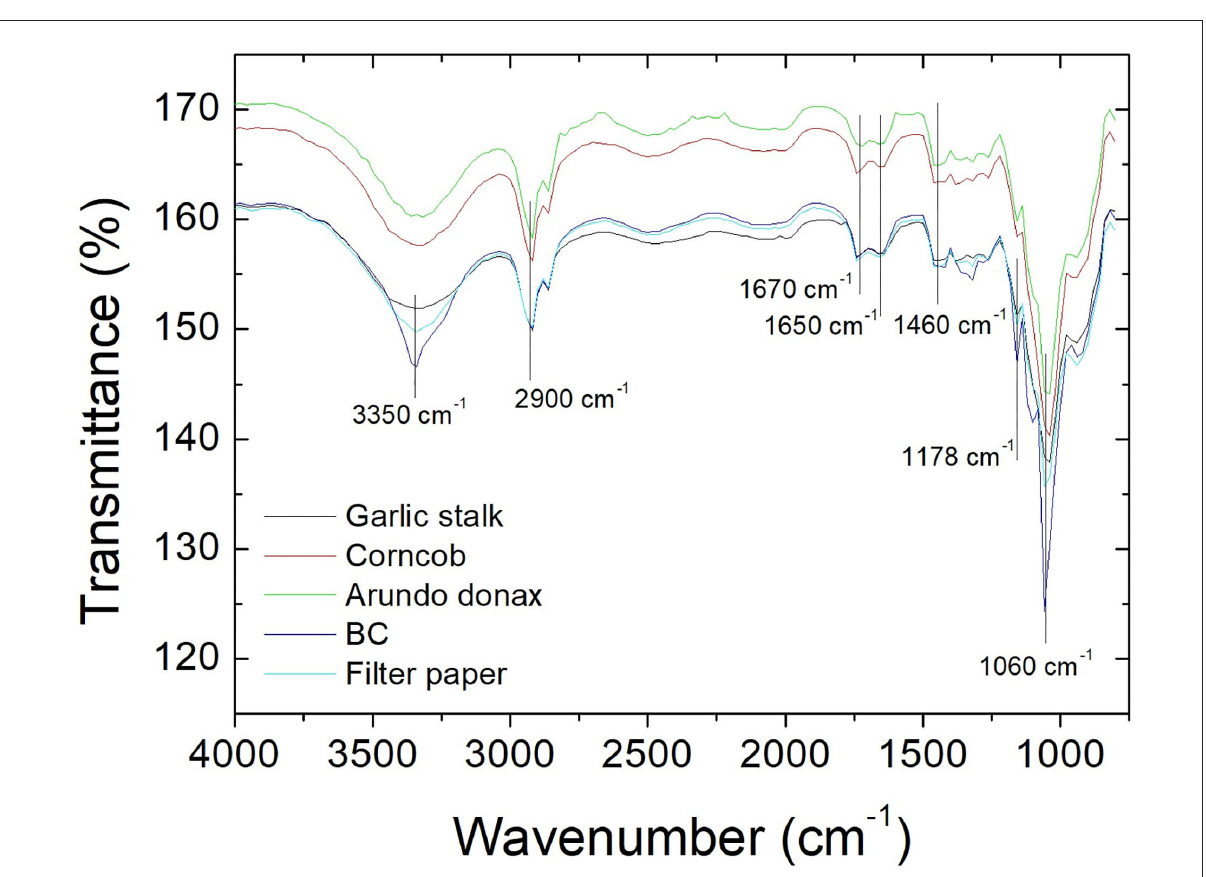
FIGURE3 FTIR-ATR spectra of cellulose extracted from the three different lignocellulosic wastes used in this work. The spectra of BC and filter paper (Whatman grade 3MM) are also reported for comparison purposes. The most characteristic peaks of the cellulosic backbone are reported.